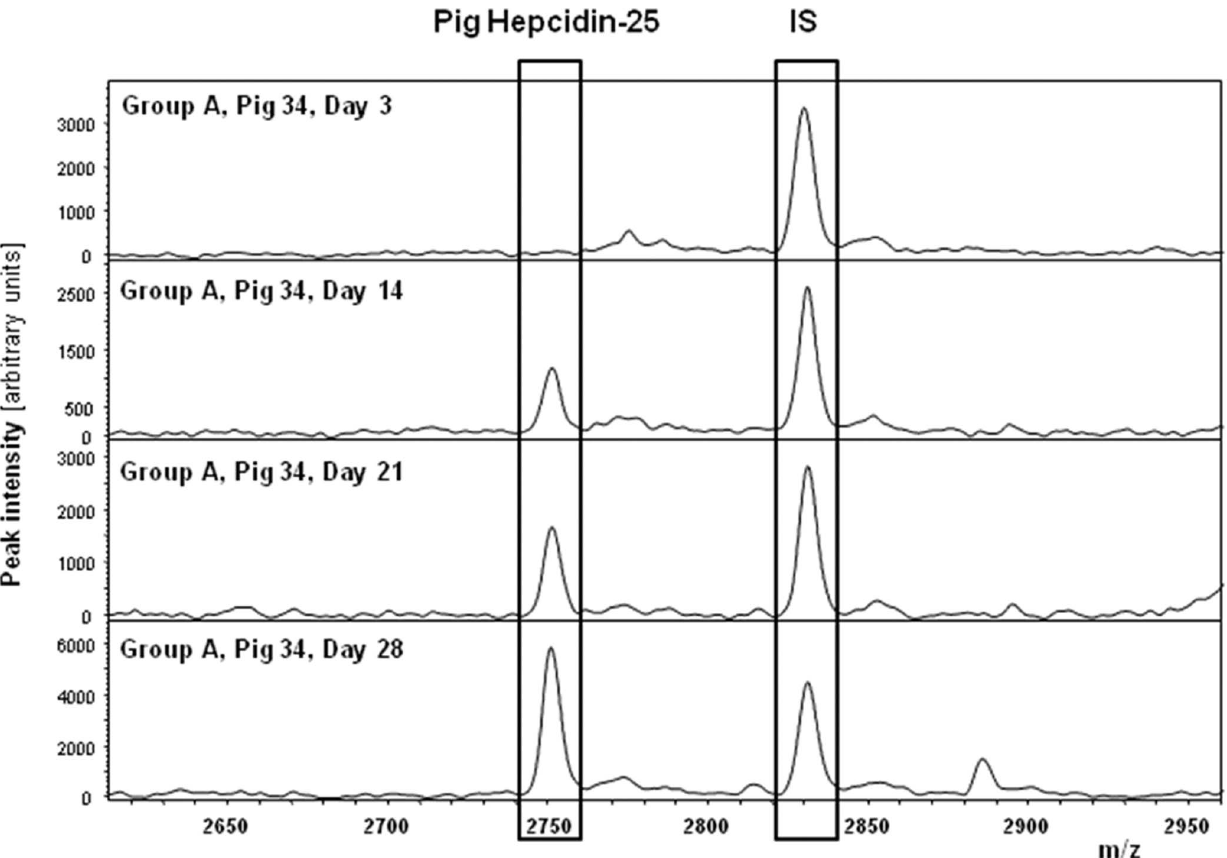
Figure 2. Pig Hepcidin-25 quantification by mass spectrometry. Hepcidin-25 measurements in piglet plasma were performed by peptide enrichment through weak cation exchange chromatography coupled to time-of-flight mass spectrometry (WCX-TOF MS). Note that quantification is based on the relative intensity of the piglet hepcidin peak with mass/charge ratio (m/z) of 2750 to that of the synthetic internal standard (IS) that is spiked in the know concentration of 10 nM to each sample prior to sample work-up. The four spectra illustrate the appearance of hepcidin-25 upon iron injection in group A, pig 34 at days 3 (baseline), 14, 21 and 28.